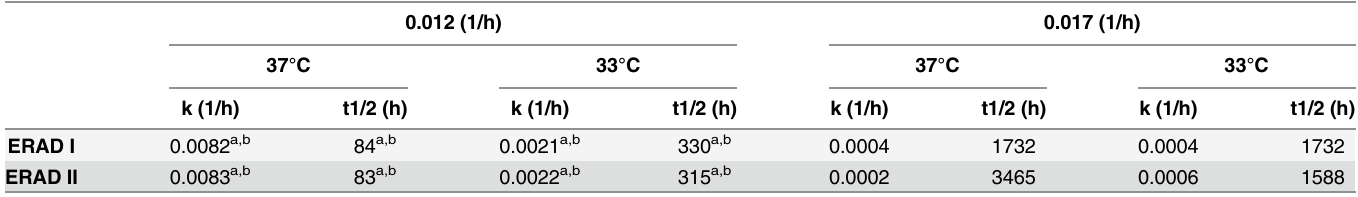
Table 3. Intracellular rht-PA half-accumulation time and accumulation constants at different temperatures and ERAD inhibition in the chemostat